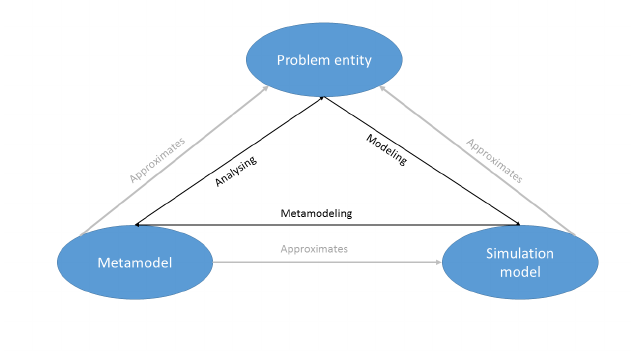
Figure 1. Metamodel